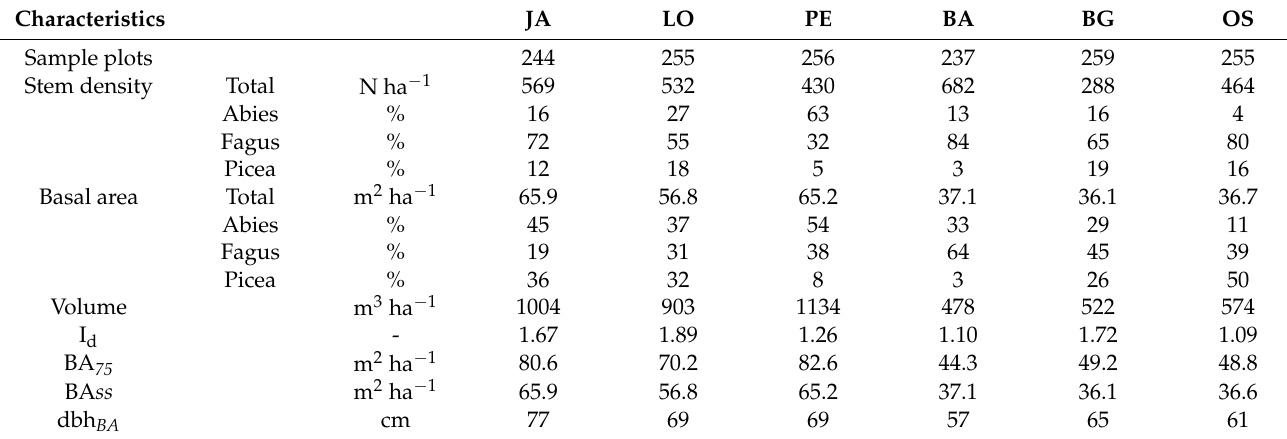
Table 2. Basic characteristics and stand-level threshold values used in the phase classification protocol in six old-growth forests in the Dinaric Mountains and Western